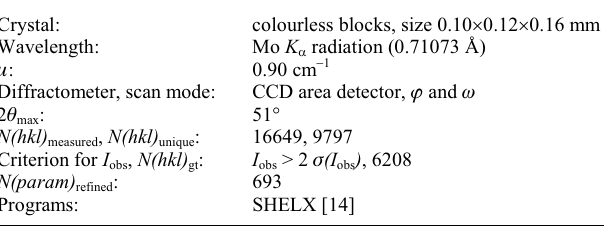
Table 1. Data collection and